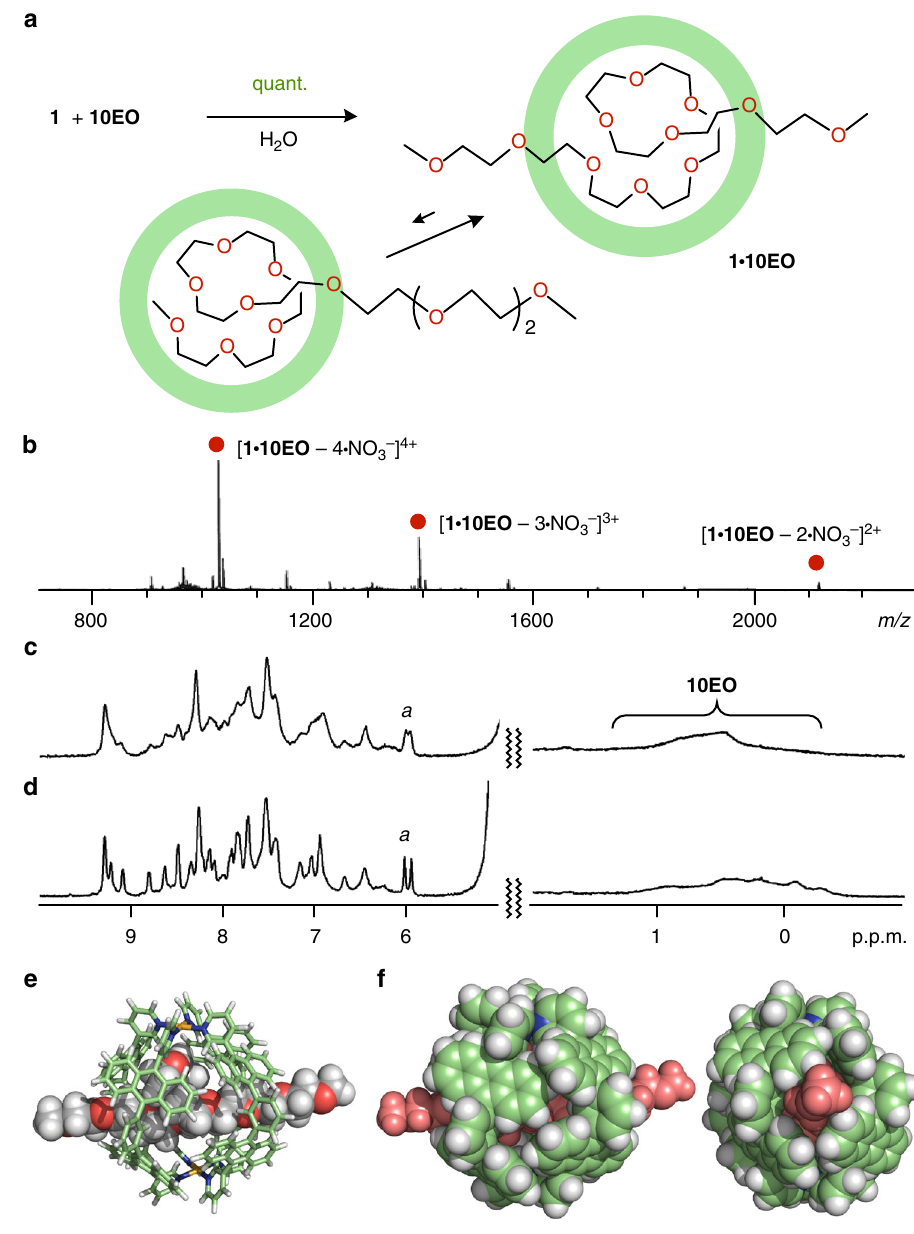
Fig. 5 Formation and characterization of host – guest complex 1 (cid:129) 10EO in a threading fashion. a Schematic representation of the formation of 1:1 pseudo- rotaxane complex 1 (cid:129) 10EO and its equilibrium mixture in water. b ESI-TOF MS spectrum (H 2 O, room temperature) of 1 (cid:129) 10EO . 1 H NMR spectra (500 MHz, D 2 O) of 1 (cid:129) 10EO at c room temperature and d 5 °C. Optimized structure of 1 (cid:129) 10EO : e cylinder and space- fi lling representation and f space- fi lling representation highlighting threaded 10EO in red (the peripheral substituents are replaced by hydrogen atoms for